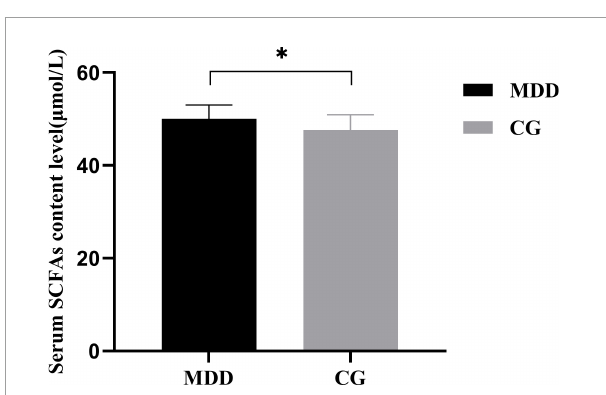
FIGURE8 Comparison of serum SCFAs content between the MDD group and the CG group. ∗ P < 0.05.